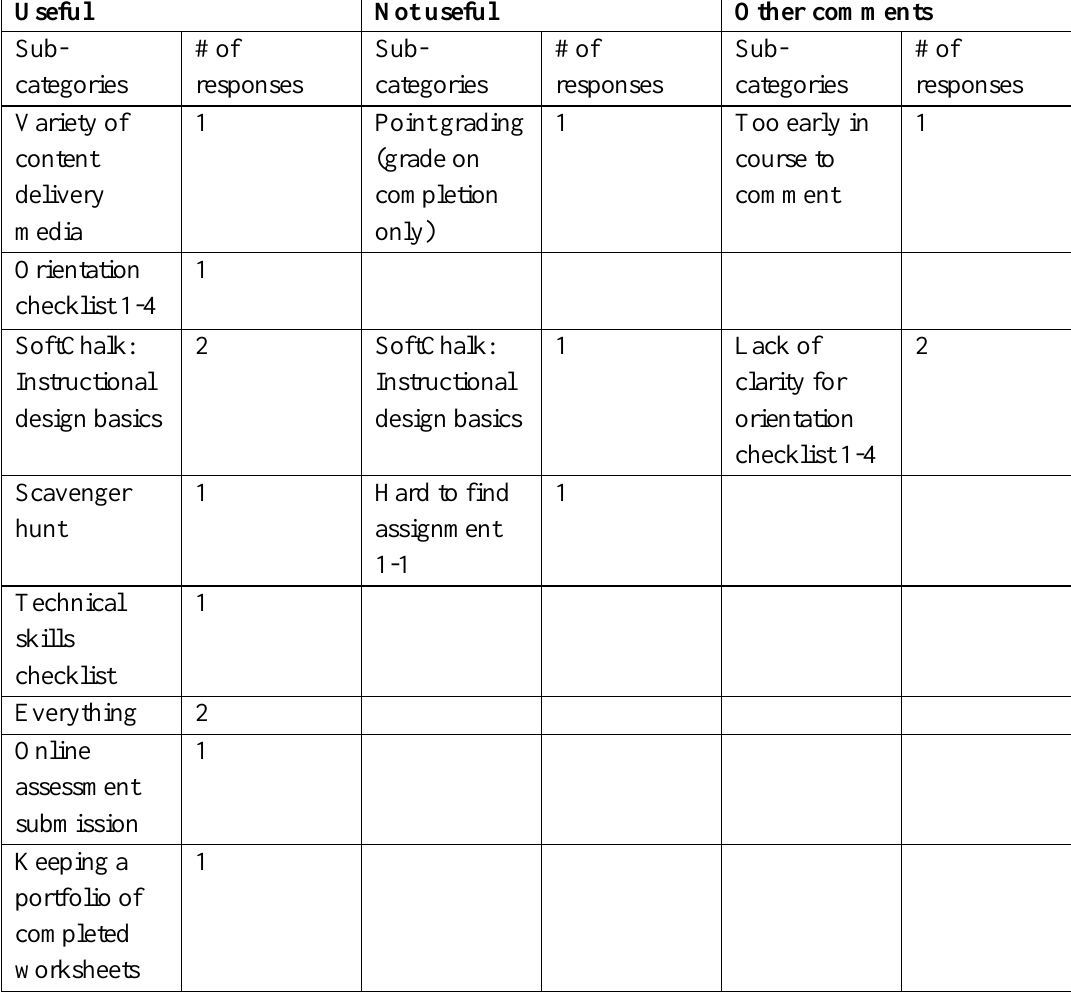
Table 5 Module One: Did any assignments stand out for you as being particularly useful, not useful? Do you have any comments you want to add about the assignments? (Each response was categorized into fields, and the number of responses indicates the total number of times that a particular topic was mentioned in all survey responses) Useful Not useful Other